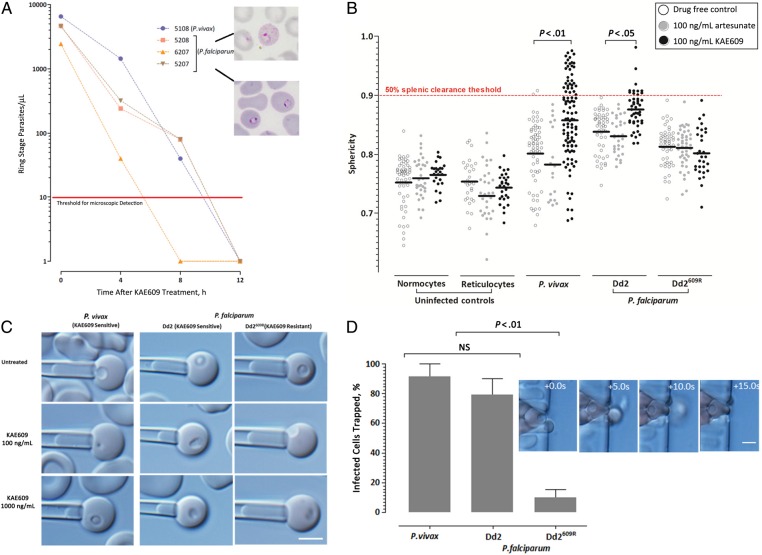
Rapid disappearance of circulating Plasmodium vivax and Plasmodium falciparum ring-stage parasites in KAE609-treated patients with malaria is due to significant changes in the morphological and rheological properties of the infected red blood cells (RBCs). A, Giemsa-stained thin blood smears from a recent phase II clinical study [2] were reread by 2 expert microscopists to determine the unreported stage of parasite development present (at admission [hour 0] and 3 subsequent sampling times). This new analysis revealed that in all 4 infected individuals (1 patient with P. vivax and 3 with P. falciparum malaria), parasites were at an synchronous young ring stage (approximately 4–8 hours after RBC invasion). No gametocytes were detected, except in the patient with P. vivax malaria (approximately 40 gametocytes per microliter). Four hours after treatment, KAE609 resulted in 78%–94% clearance of the parasites, including 100% of all P. vivax gametocytes. No parasites could be detected 12 hours after treatment (red line indicates microscopic threshold of detection). Note the Giemsa-stained thin film images of representative P. vivax (upper inset) and P. falciparum (lower inset) ring-stage–infected RBCs present in the samples. B, Micropipette aspiration was used to determine the sphericity (sphericity index [SI] of 1 indicates a perfect sphere) of RBCs infected with ring-stage malaria parasites that were either sensitive (P. vivax [6 isolates] and P. falciparum Dd2 [3 independent trials]) or resistant (P. falciparum Dd2R609 [6 independent trials]) to spiroindolone (KAE609) and/or artesunate after 2 hours of treatment with 100 ng/mL of these drugs. The sphericity of infected RBCs of P. vivax (median SI, 0.801–0.858; P < .01) and Dd2 (median SI, 0.838–0.876; P < .05) treated with KAE609 significantly increased relative to drug-free controls. However, no change was detected in P. falciparum Dd2R609 (median SI, 0.813–0.811; P = .39). Red dotted line (extrapolated from ex vivo human spleen data [9]) indicates the threshold sphericity (SI >0.9) at which ≥50% of RBCs will be cleared. Only P. vivax– and Dd2 P. falciparum–infected RBCs treated with KAE609 show an appreciable proportion (>20% of the cell population) of cells with an SI >0.9. Importantly. none of the drug treatments have any effect on the SI of uninfected RBCs. Each circle represents a single infected RBC. C, The effect of KAE609 on the deformability of infected RBCs, is illustrated by the length of the aspirated cell at an aspiration pressure of 588.6 Pa (ie, infected RBCs with a lower shear modulus/higher deformability will have a longer aspirated tongue). Thus, in the case of the sensitive P. vivax– and Dd2-infected RBCs, treatment with 100 and 1000 ng/mL KAE609 results in discernibly shorter aspirated cell lengths compared with the KAE609-resistant clone Dd2R609. D, Increase in sphericity of KAE609-treated P. vivax– and P. falciparum Dd2–infected RBCs resulted in a significantly (P < .01) higher median percentage of infected RBC (normalized for parasitemia) trapping in 2-µm microfluidic restrictions (which model the splenic sinusoidal slits), compared with the KAE609-resistant clone (Dd2R609). The inset to the left of the bar graph shows a 15-second sequence (5-second frames) of a drug-affected Dd2 trapped in the 2-µm gap (almost all infected RBCs remain trapped for the duration [5–15 minutes] of the experiment). (For the video version of this inset, see Supplementary Figure 3.)